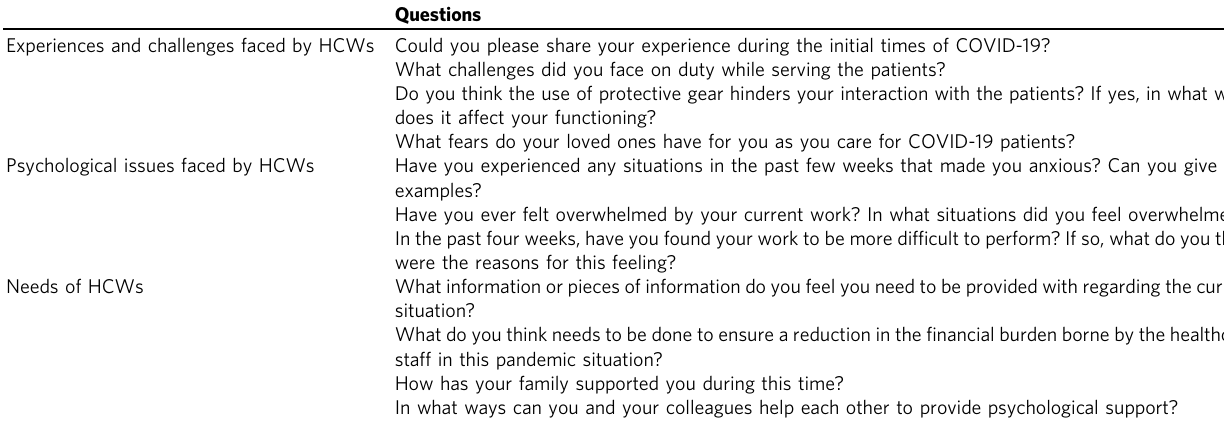
Table 1 Examples of interview questions/prompts.